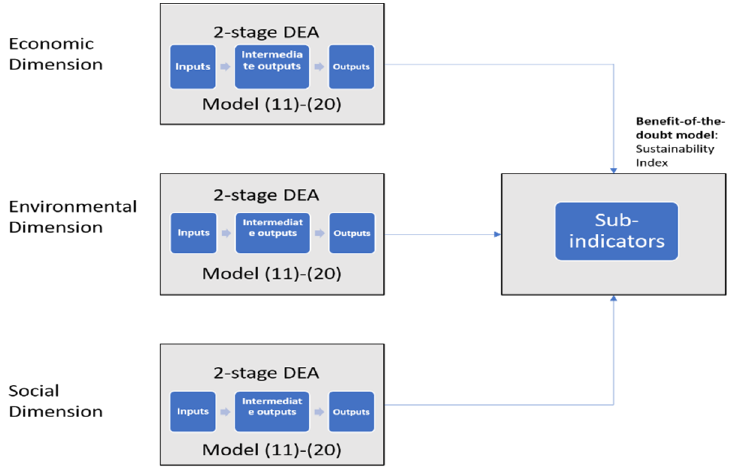
Figure 2. Framework for the construction of composite indicators proposed by Tsaples and Papathanasiou [79].